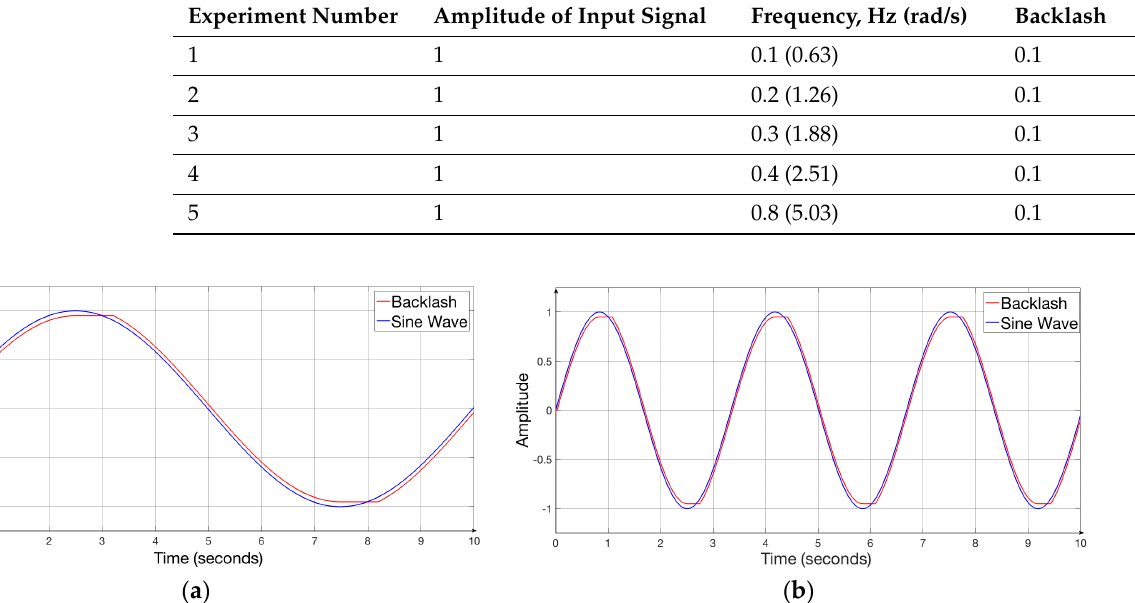
Table 2. Initial data and data analysis of both experiments. Experiment Number